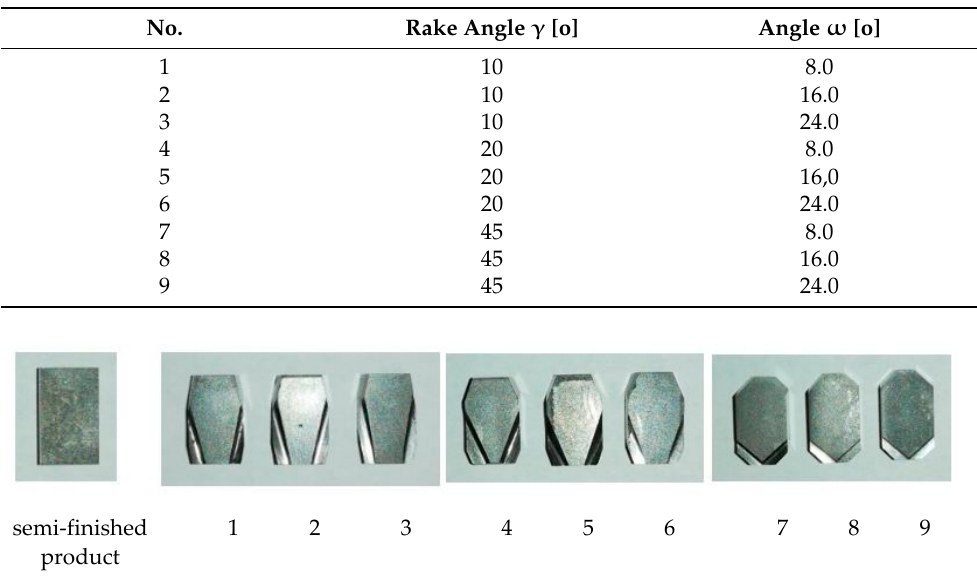
Figure 5. Pictures of cutting inserts. Designations according to Table 4.